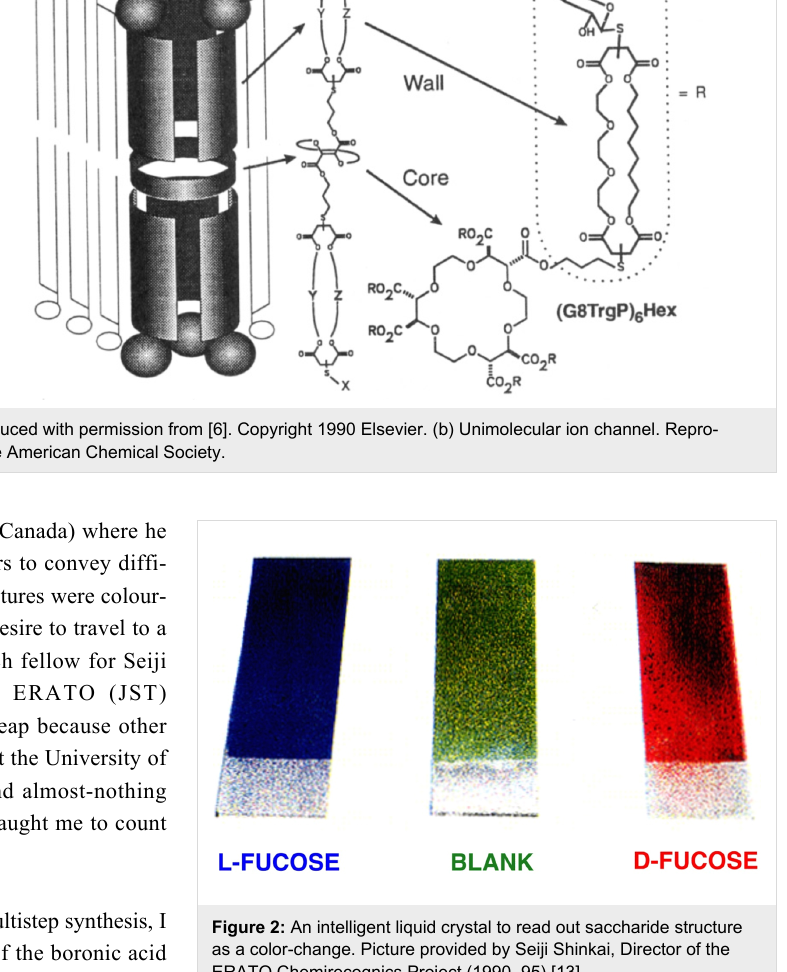
Figure 2: An intelligent liquid crystal to read out saccharide structure as a color-change. Picture provided by Seiji Shinkai, Director of the ERATO Chemirecognics Project (1990–95)